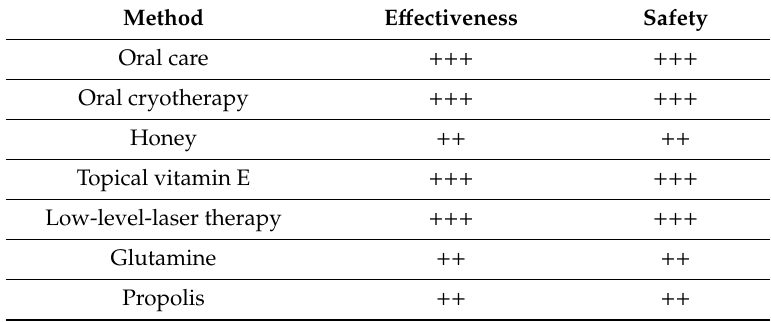
Table 3. Suggestions regarding prophylaxis of chemotherapy-induced oral mucositis.